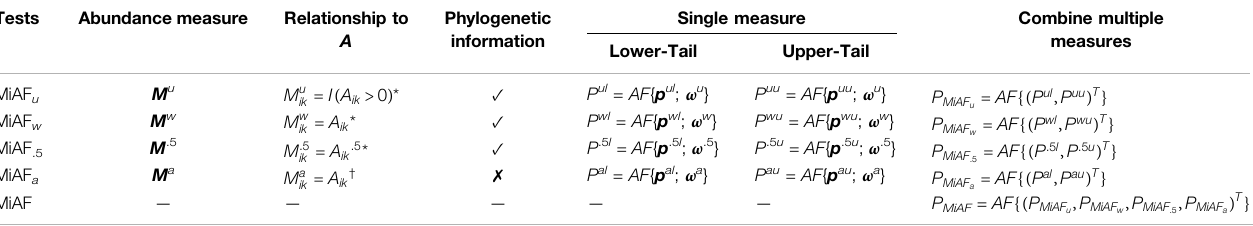
TABLE 1 | MiAF implementation